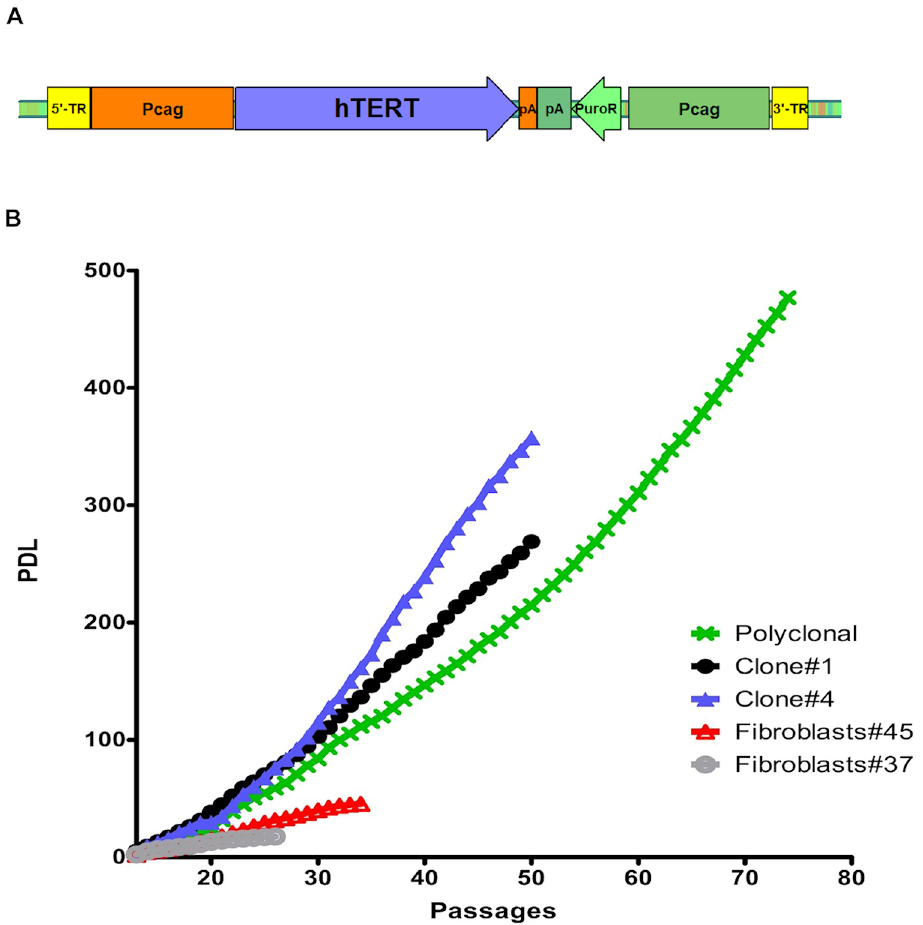
Fig 1. pTT-PB-hTERT-puro plasmid map and population doubling levels (PDL) of immortalized marmoset fibroblasts. (A) The piggyBac construct used for immortalization. Human TERT is under control of the CAG promoter (Pcag). pA: poly A signal; 5 ˈ -TR: 5 ˈ -terminal repeat; 3 ˈ -TR: 3 ˈ -terminal repeat; PuroR: puromycin resistance gene. The latter one is also under the control of a separate CAG promoter. (B) Cell population doubling levels (PDL). PDL was determined according to equation: PDL(n/n-1) = log (Nf/N0)/log 2; n = passage number, Nf = final number of cells, N0 = number of cells seeded at passage.